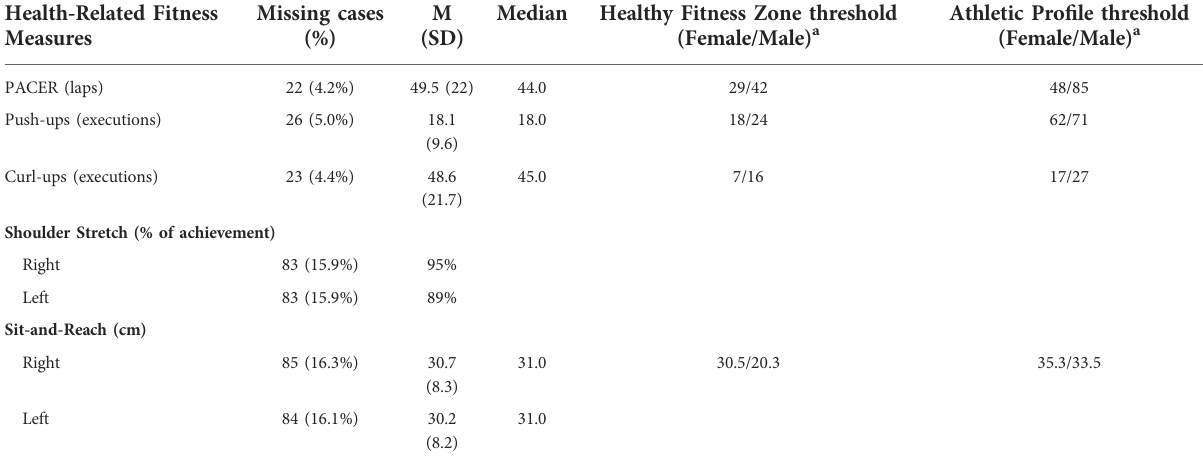
TABLE 5 Descriptive statistics for teacher-reported results for the health-related fi tness module ( N =515) and their reference thresholds.